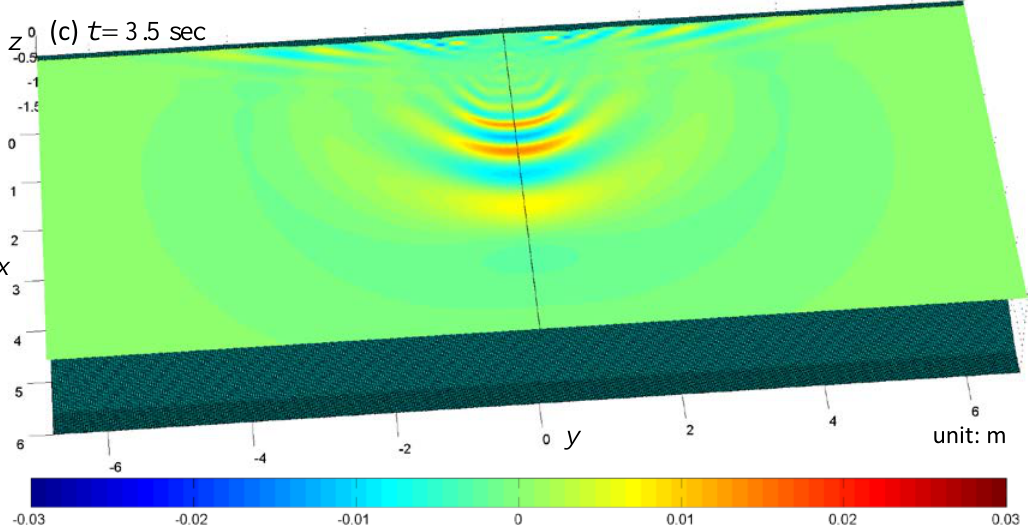
Figure 13. Snapshots of the free surface elevation in case 1 in a wider wave flume. ( a ): t = 0.5 sec; ( b ): t = 2.0 sec; ( c ): t = 3.5 sec.